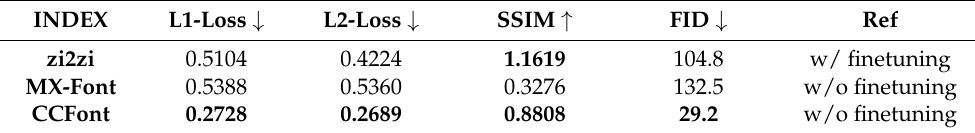
Table 2. Quantitative comparative evaluation of the proposed method and the baselines.